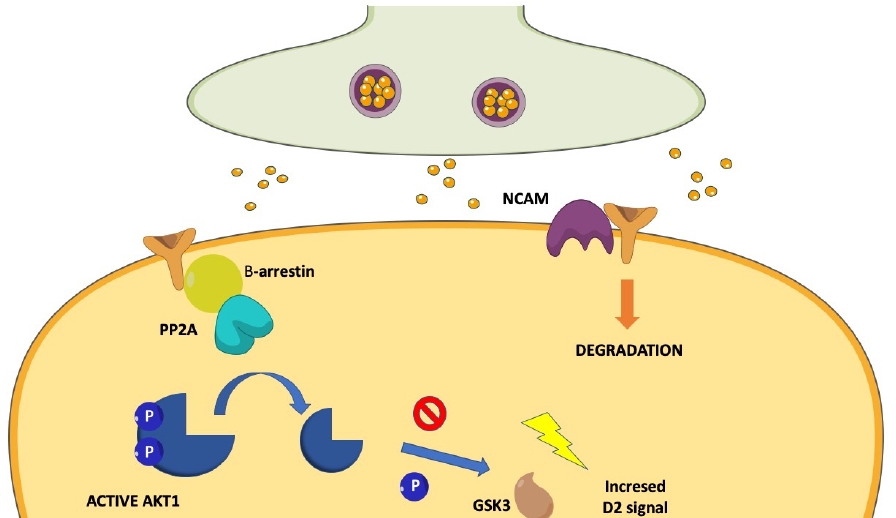
Figure 7. Putative postsynaptic molecular mechanisms of treatment resistance: the β -arrestin-2 pathway and the NCAM. β -arrestin-2 pathway may promote D2R-mediate postsynaptic signaling. The interaction of D2R with β -arrestin promotes the recruitment of PP2A, which in turn disables AKT1. The lack of inactivation of GSK-3 causes hyperactivity of D2R-mediated signaling. Excessive activation of this pathway has been considered a putative mechanism of non-response to antipsychotics. NCAM is a transmembrane protein that interacts with D2Rs and mediates their degradation. NCAM -/- mutant mice showed an increased membrane expression of D2Rs and excessive D2R-mediated postsynaptic signaling, which may counteract the effects of antipsychotic agents predisposing to non-response.